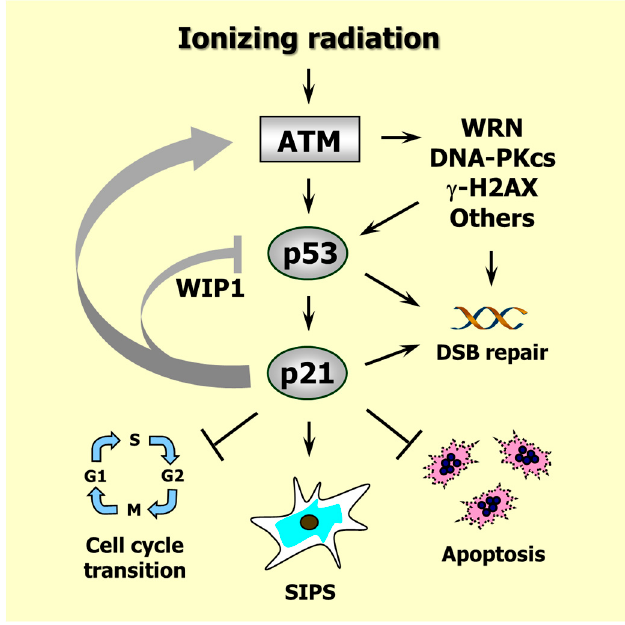
Figure 5. Responses induced by ionizing radiation in p53 wild-type human solid tumor-derived cell lines. Arrows indicate stimulation and T-shaped lines indicate inhibition. Radiation exposure results in ATM-dependent activation of several proteins (e.g., p53, WRN, DNA-PKcs) that play important roles in DSB repair, as well as p53-mediated activation of p21 that suppresses apoptosis and activates cell cycle checkpoints. Proper activation of these events provides time for the repair of potentially cytotoxic and mutagenic lesions. Persistence of DNA damage leads to sustained induction of p21 which downregulates p53 (e.g., through WIP1), suppresses apoptosis and triggers SIPS. Positive feedback loops between ATM and p21 ensure the maintenance of the SIPS response for extended times (e.g., several months in culture). For further details, consult [31,37]. WRN, Werner’s syndrome protein; DNA-PKcs, DNA-dependent protein kinase catalytic subunit; γ -H2AX, H2A variant histone H2AX phosphorylated on Ser 139; WIP1, wild-type p53-induced phosphatase 1.